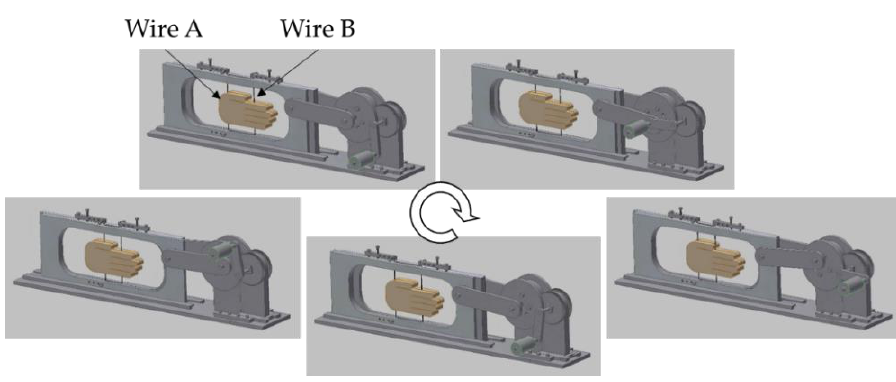
Figure 8. Images of movements of two parallel wires with phase difference of 180°.